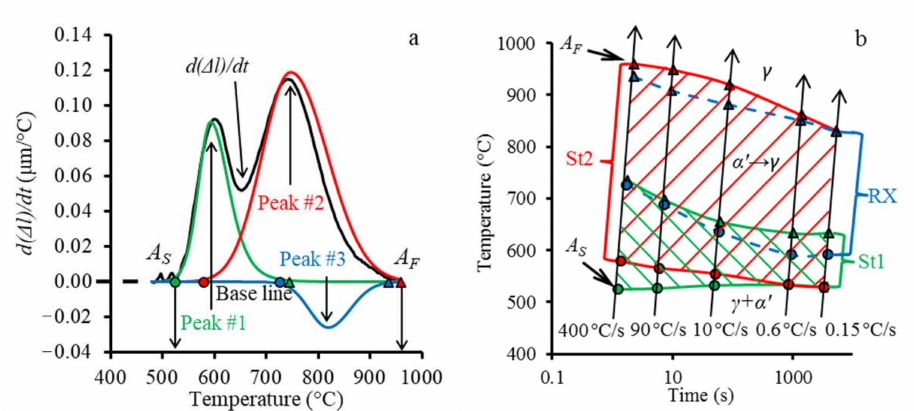
Figure 4. ( a ) The scheme of fitting the d( ∆ l)/dt-curve and ( b ) the reversion-temperature-time diagram for the as-processed program steel. Notation: St1—first reversion stage; St2—second reversion stage;